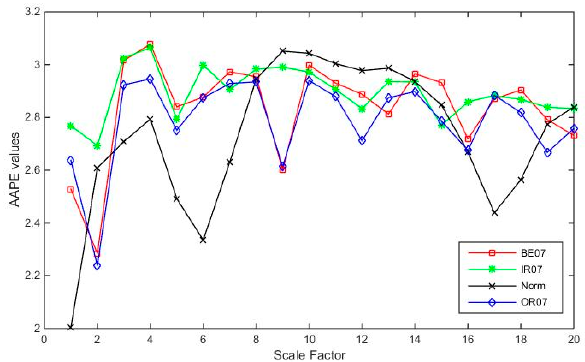
Figure 9. IMAAPE feature vectors for different fault types under the fault diameter of 7 mils with the load 0 hp.